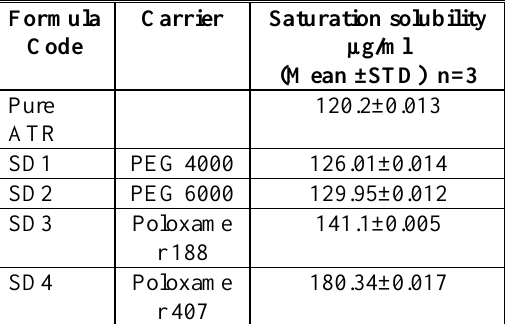
Table 3.The solubility of pure ATR and SDs formulas using different carriers with drug: carrier ratio 1:1 in distilled water at 25˚C.